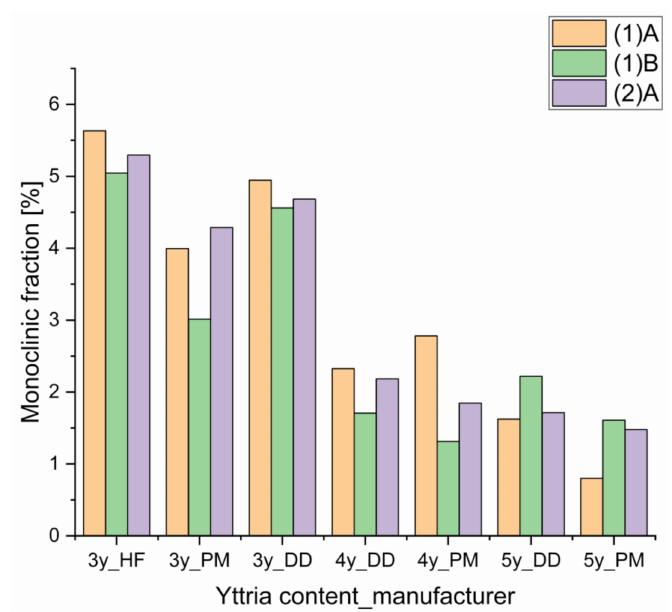
Figure 5. Monoclinic phase fraction of the different Y-TZP ceramics with different yttria contents (3–5 mol%) and different manufacturers identified at positions (1)A (untreated), (2)A (after thermo- cycling), and (1)B (after grinding) (cf. Figure 1) determined according to the formula of Nicholson and Garvie